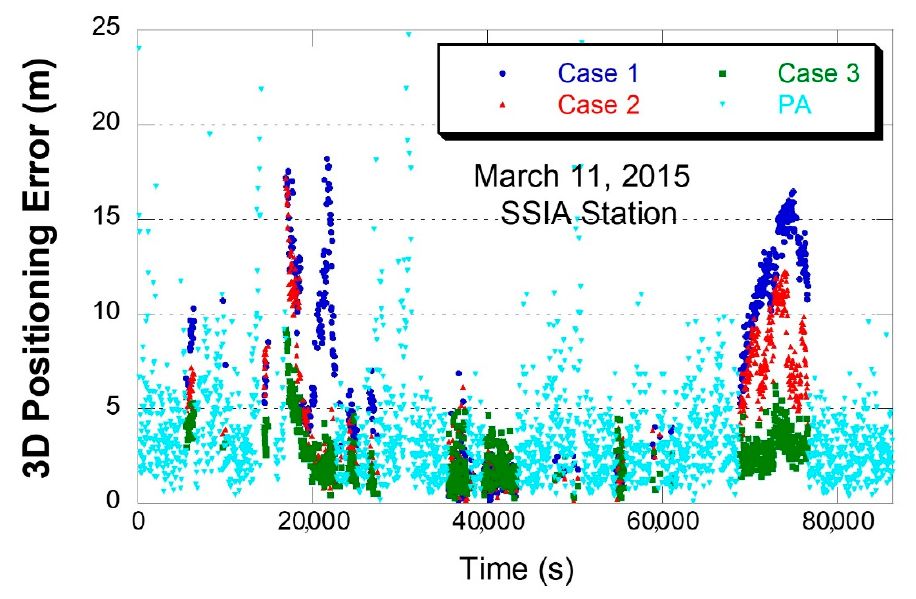
Figure 8. 3D positioning errors by different positioning methods at the SSIA station on March 11, 2015.